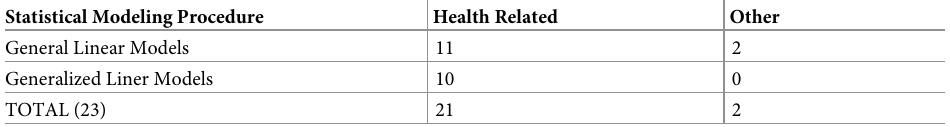
Table 2. Statistical models used in analysing step count data in relation to the scope of the article: Effect OF step